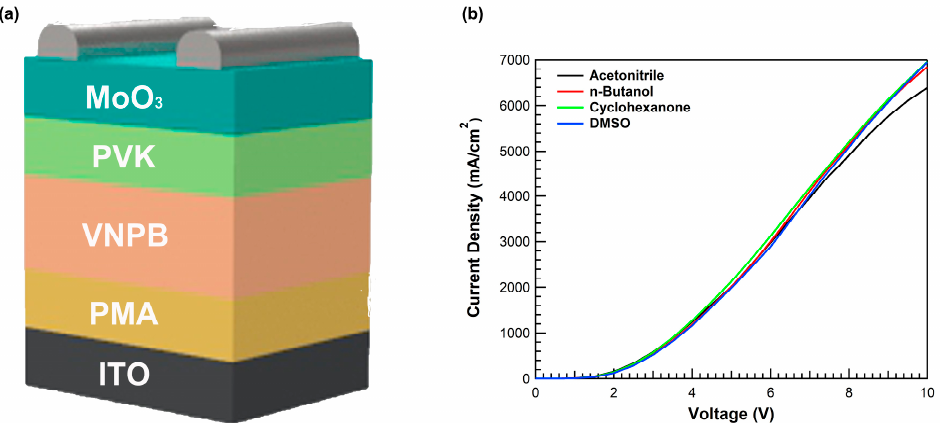
Figure 4. ( a ) Device structure of HOD and ( b ) current density–voltage characteristics using PMA as HIL with various solvents.